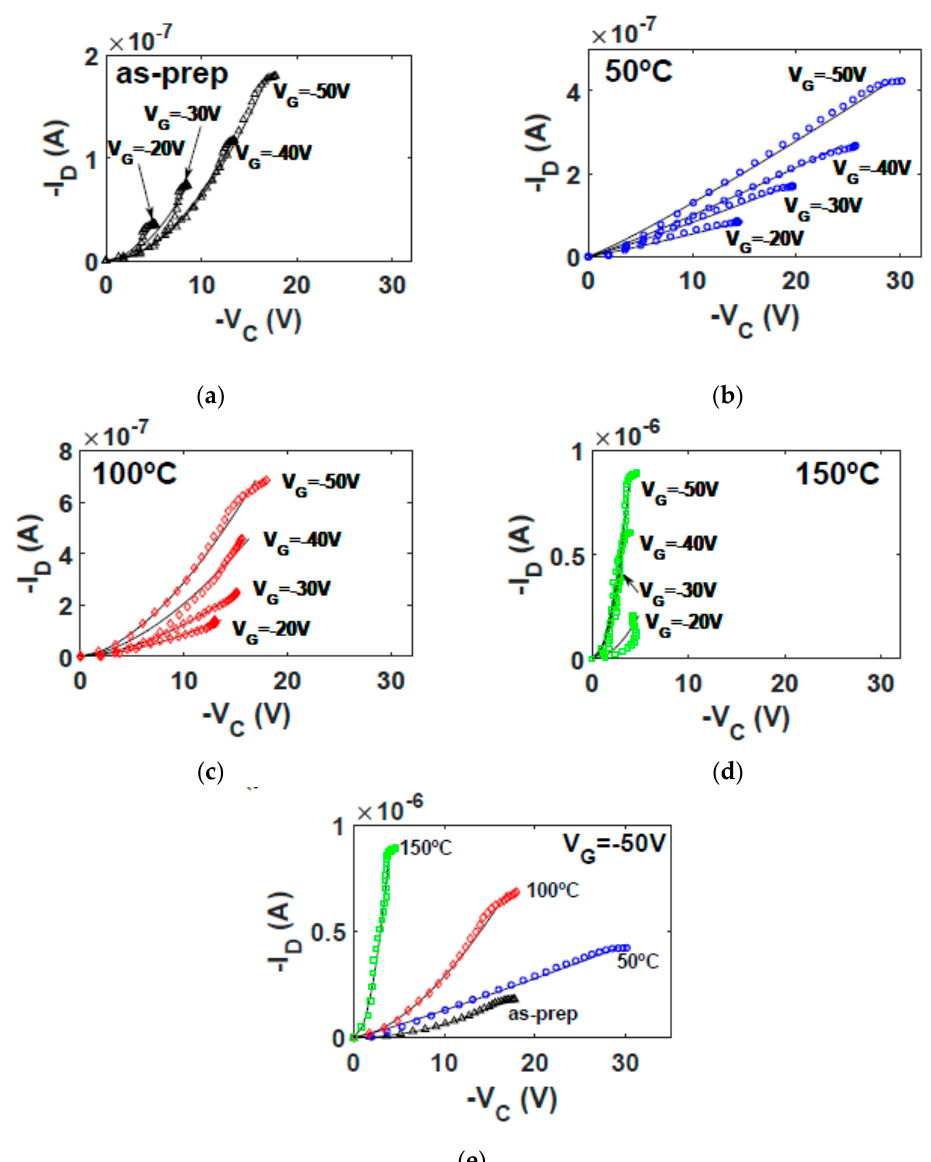
Figure 6. Contact I D − V C curves in NiPc 6 OTFTs at di ff erent annealing temperatures. ( a – d ) Comparison of I D − V C curves calculated with Equation (20) (symbols) and Equation (18) (solid lines) at di ff erent annealing temperatures: ( a ) as-prepared; ( b ) 50 ◦ C; ( c ) 100 ◦ C; and ( d ) 150 ◦ C. ( e ) Comparison of I D − V C curves calculated with Equation (20) (symbols) and Equation (18) (solid lines) at V G = − 50 V and di ff erent annealing temperatures.